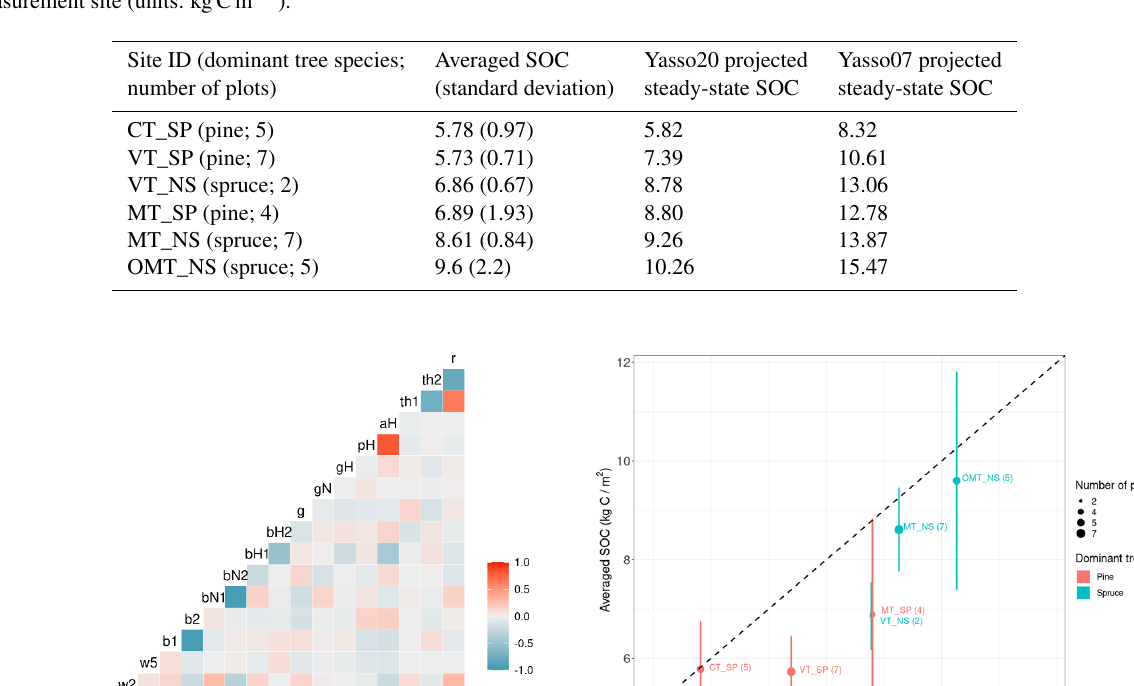
Table 4. Averaged measured SOC and projected SOC values with both Yasso07 and Yasso20 for forest plots in Hyytiälä, Finland, classified by measurement site (units: kgCm − 2 ).